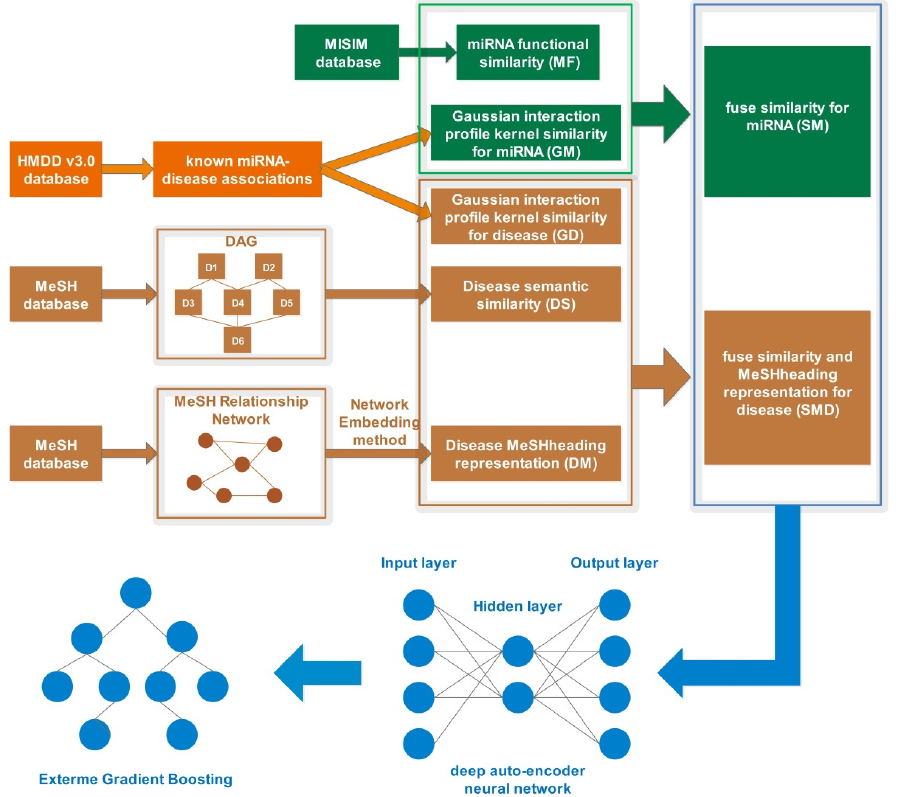
Figure 1. Flowchart of SMMDA to predict potential miRNA-disease associations.